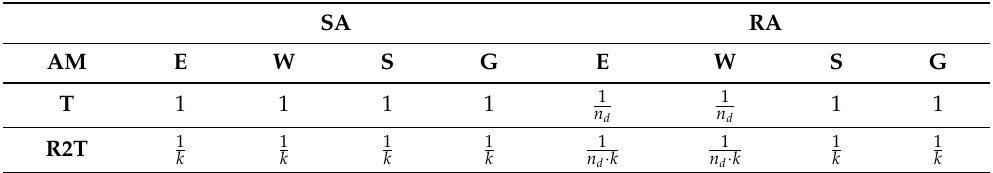
Table 1. Comparison between Tor ( T ) and Ring2Tor ( R2T ). Shown are the probabilities of the adver- saries breaking the properties SA and RA .